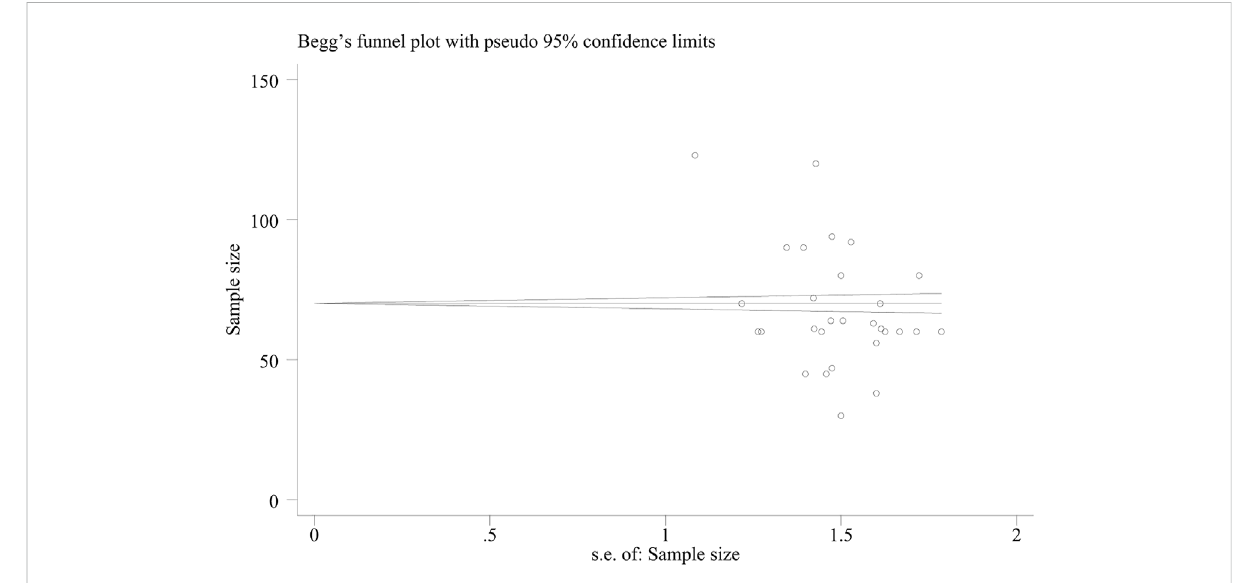
FIGURE 11 Begg ’ s funnel plot of total clinical